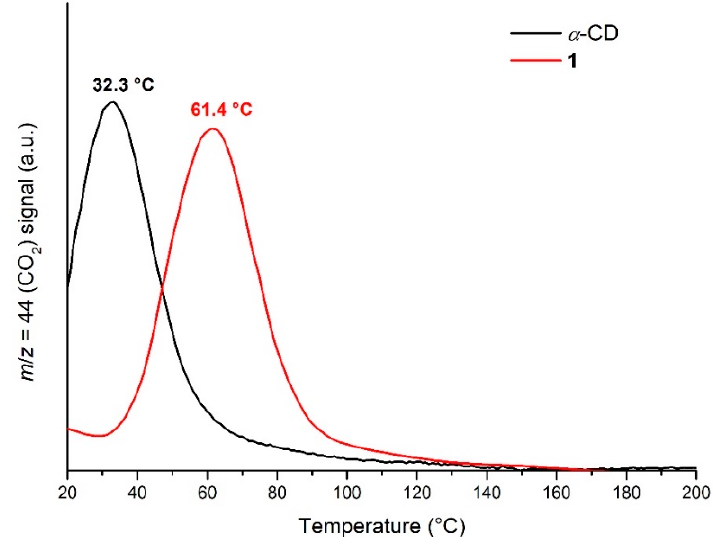
Figure 2. CO 2 -TPD curves of the examined α -CD and 1 samples.